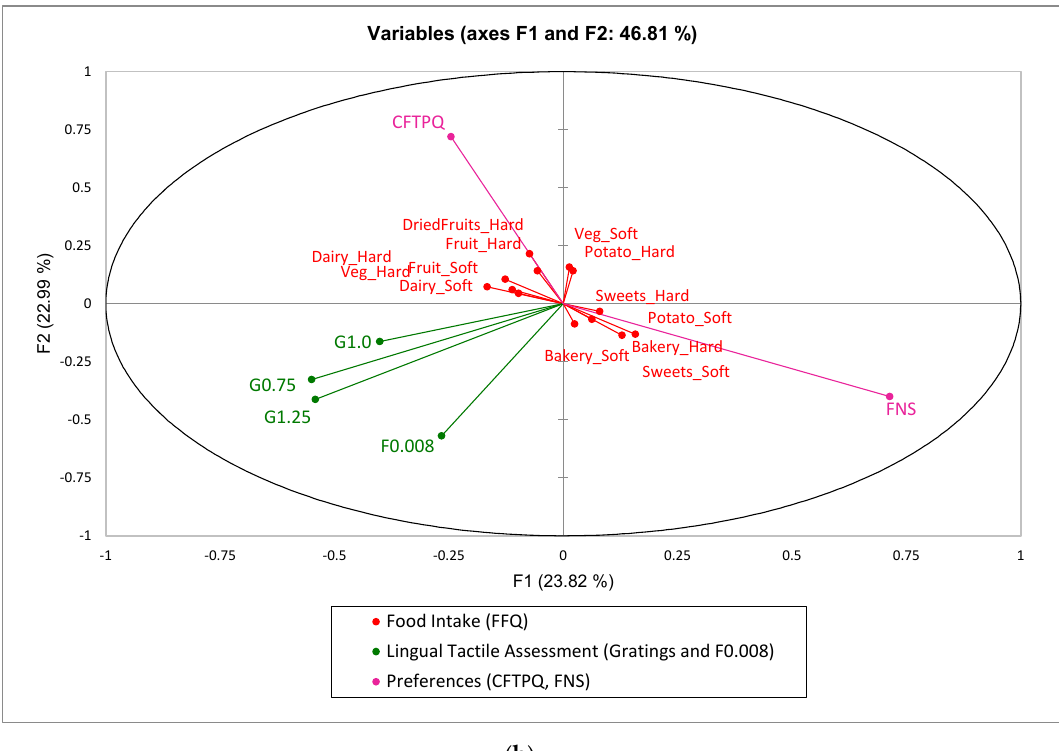
Figure 8. ( a , b ). Observations and variable plots from a multifactor analysis (MFA) performed on lingual tactile sensitivity (4 variables: F0.008, G0.75, G1.0 and G1.25); preference measured (2 variables: Child Food Texture Preference Questionnaire (CFTPQ) and Food Neophobia Scale (FNS) scores) and the food frequency of consumption, FFQ (13 variables). Active tables were set as the lingual tactile assessment and preference measures, with the FFQ as a supplementary table.